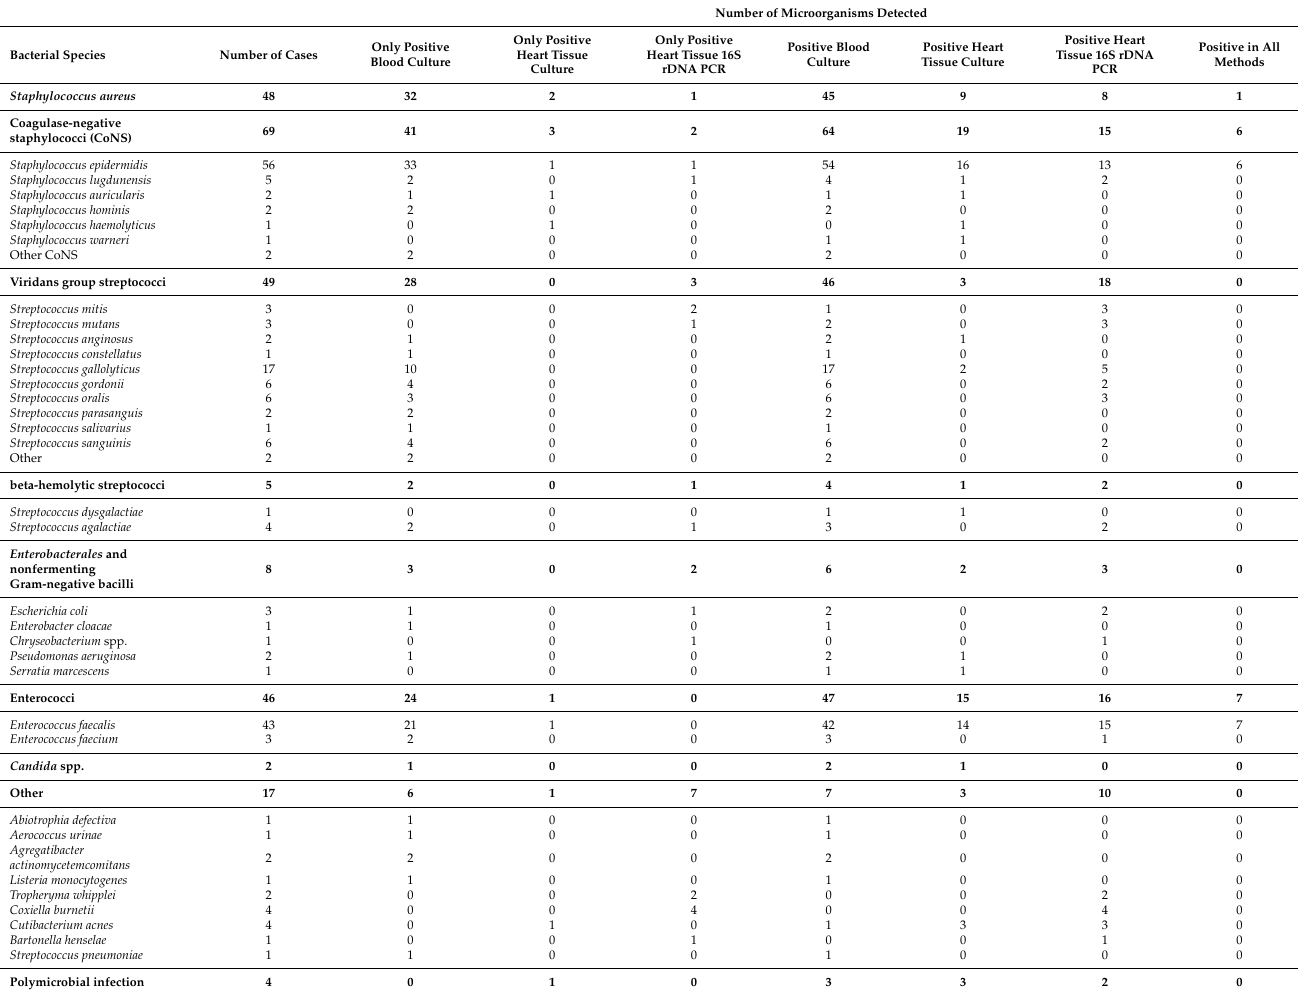
Table 2. Microbiological results grouped by species of patients diagnosed with infective endocarditis.